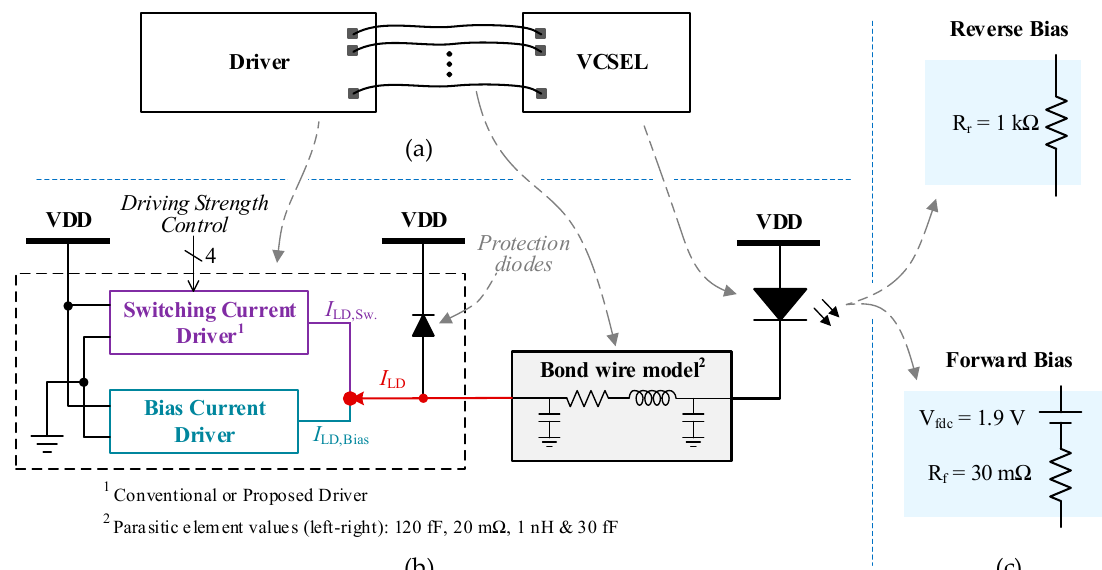
Figure 7. ( a ) A typical VCSEL and driver connection using die-to-die bonding, ( b ) Simulation setup, realization of the typical VCSEL/driver connection, ( c ) Linear piece-wise model of the VCSEL.